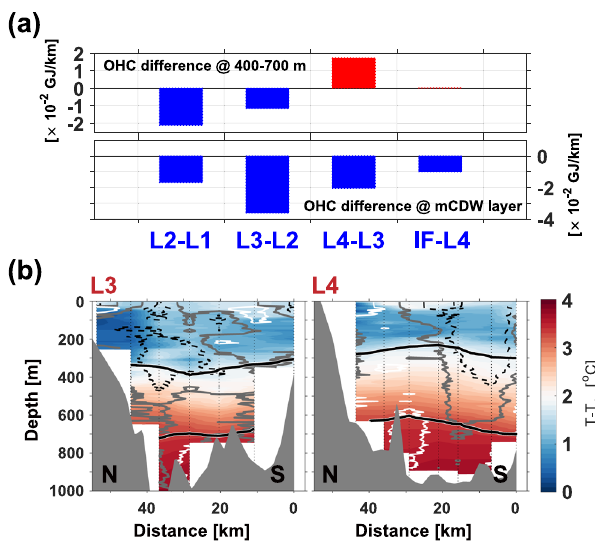
Fig. 4 Ocean heat content for each north – south section. a Bar graphs denote the differences in ocean heat content (OHC) among the observational lines relative to the line distance in the depth layer of 400 – 700 m (upper panel) and mCDW layer (lower panel) (Supplementary Table 1). b Vertical section of the temperature above the in situ freezing point along the L3 (left panel) and L4 (right panel; Fig. 1a) sections. Dashed black and solid white contours indicate a 5 cm/s out fl ow from the PIIS cavity and in fl ow to the PIIS cavity, respectively. Solid grey contours indicate zero velocity. Solid black contours denote the 27.47kg/m 3 and 27.75 kg/m 3 (potential density) isopycnals in